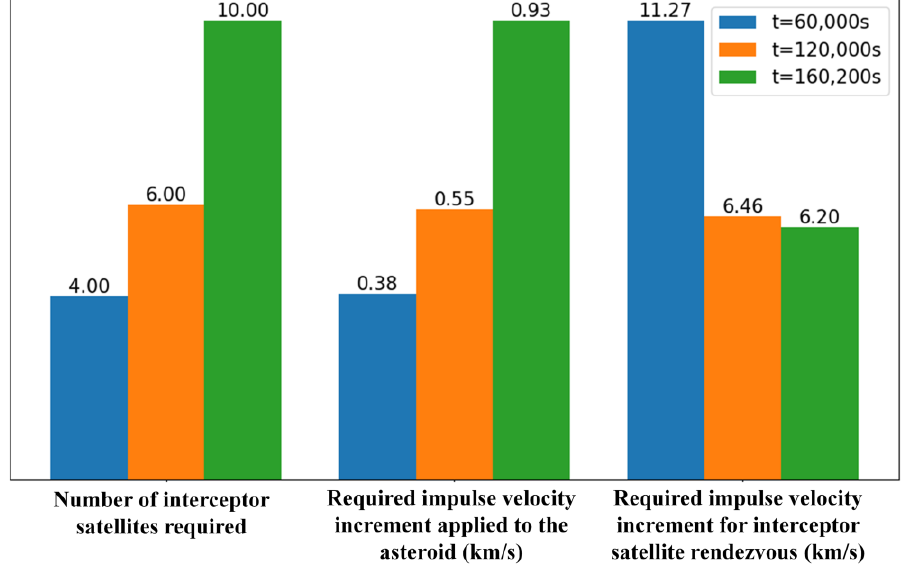
Figure 10. Comparison of evaluation indices.